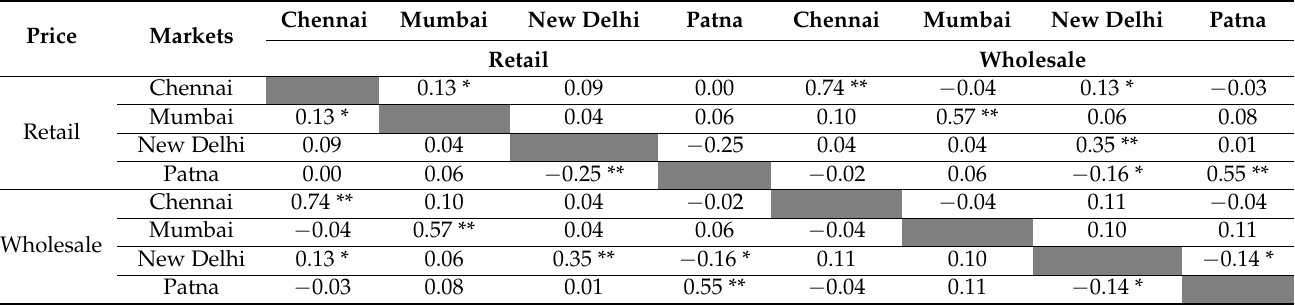
Table 6. Estimates of the correlation for rice